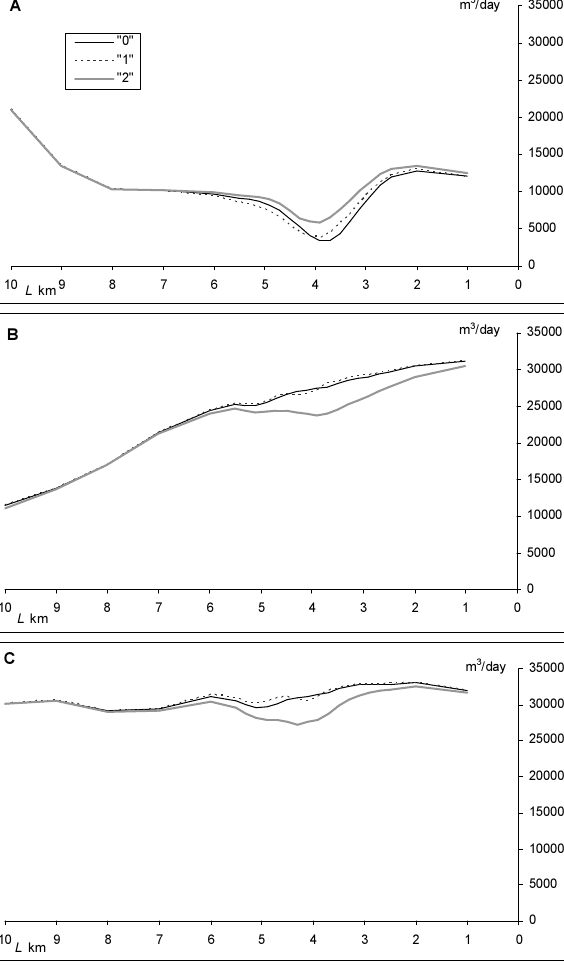
Fig. 9. Distribution of sediment discharge (m³/day) from 10 cross-section (the Ošupis stream) to 1 LT-LV border) for “0”, “1”, and “2” alternatives blowing wind of NW (A), W (B) and SW (C)